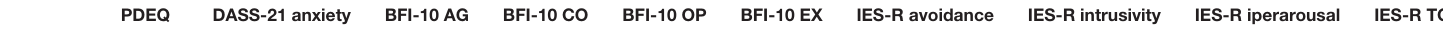
TABLE 2 | Spearman correlations among emotional and psychological measurements in March 2020 evaluations correlation